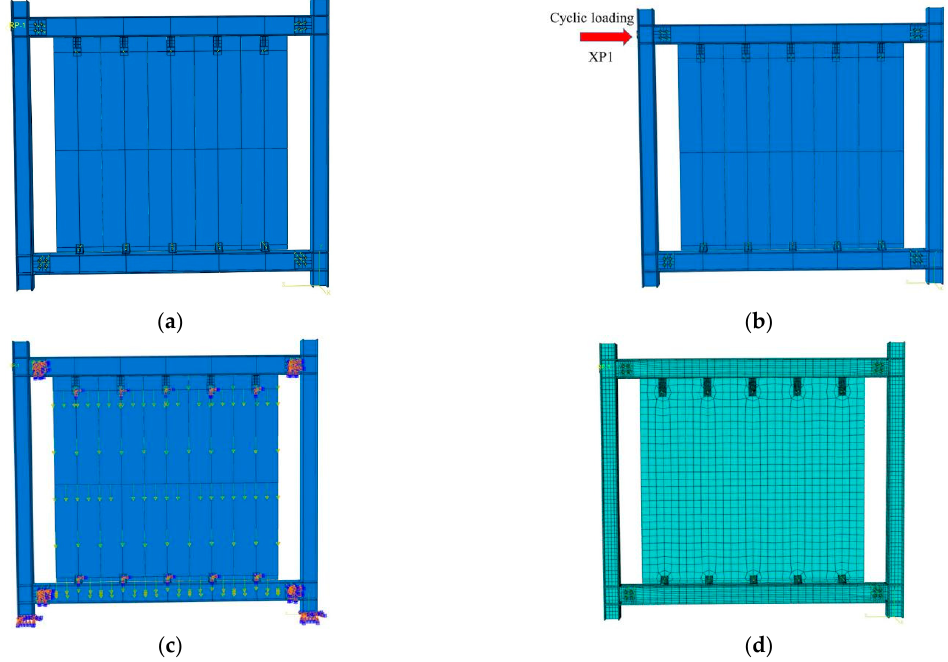
Figure 17. The constructed model and mesh subdivision. ( a ) Finite element model. ( b ) Cyclic loading. ( c ) Boundary conditions. ( d ) Mesh subdivision.